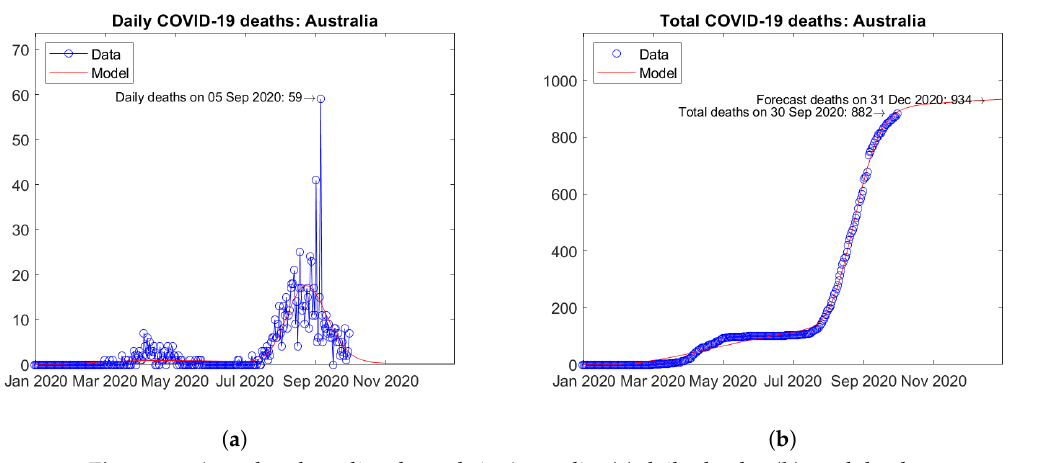
Figure 31. Actual and predicted trends in Australia: ( a ) daily deaths, ( b ) total deaths.